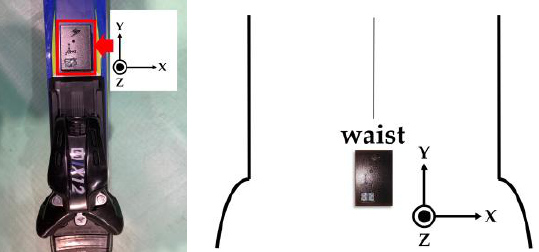
Figure 2. The inertial sensors were set on the skis in front of each binding ( left pane ) and on the skier’s waist at the L5-S1 position of the vertebral column ( right pane ).